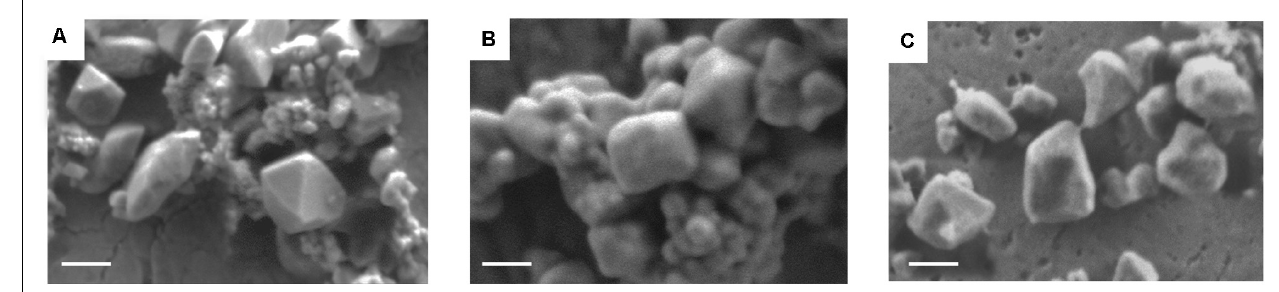
FIGURE 2 | Representative scanning electron microscope (SEM) images of nanoMOFs before and after lipid modification. (A) nanoMOFs; (B) nanoMOFs after modification with DOPC; (C) nanoMOFs after modification with DOPC and DSPE-PEG 2000. Scale bar: 100 µ m.